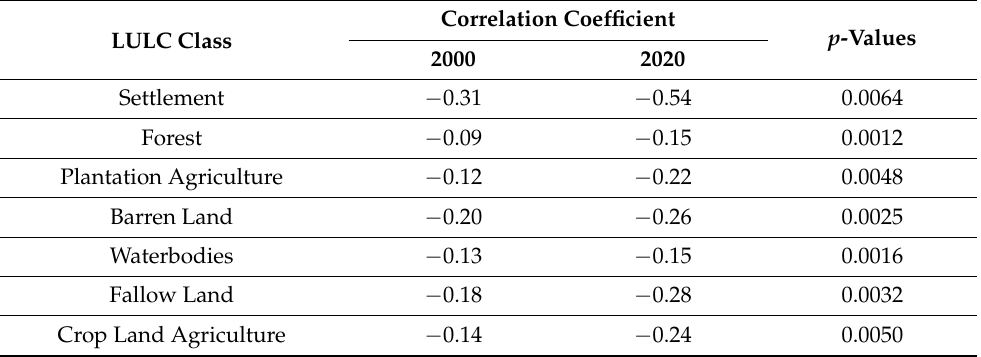
Table 10. Spearman correlation between Vegetation Condition Index (VCI), Vegetation Health Index (VHI), and Land Surface Temperature (LST) by landuse and landcover (LULC) zones. All correlation coefficients are statistically significant at p ≤ 0.01. Correlation Coefficient p -Values LULC Class 2000 2020 Settlement − 0.31 − 0.54 0.0064 Forest − 0.09 − 0.15 0.0012 Plantation Agriculture − 0.12 − 0.22 0.0048 Barren Land − 0.20 − 0.26 0.0025 Waterbodies − 0.13 − 0.15 0.0016 Fallow Land − 0.18 − 0.28 0.0032 Crop Land Agriculture − 0.14 − 0.24